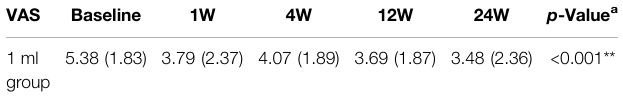
TABLE 2 | Primary outcome in the three groups: mean VAS. VAS Baseline 1W 4W 12W 24W p -Value a 1 ml 5.38 (1.83) 3.79 (2.37) 4.07 (1.89) 3.69 (1.87) 3.48 (2.36) < 0.001** group 2 ml 5.93 (2.07) 4.51 (2.39) 4.00 (2.74) 3.50 (2.57) 2.79 (2.22) < 0.001** group 4 ml 5.40 (1.51) 3.02 (1.82) 1.88 (1.76) 1.55 (1.91) 2.24 (2.34) < group